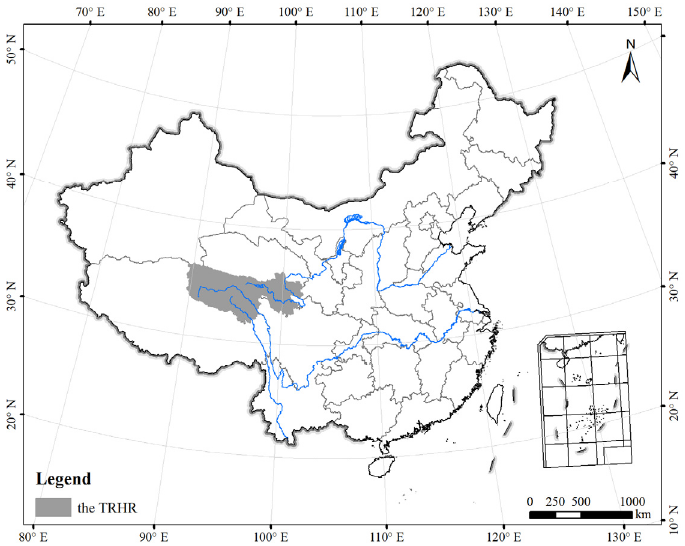
Figure 1. The distribution of the Three-River Headwaters Region (TRHR), China.